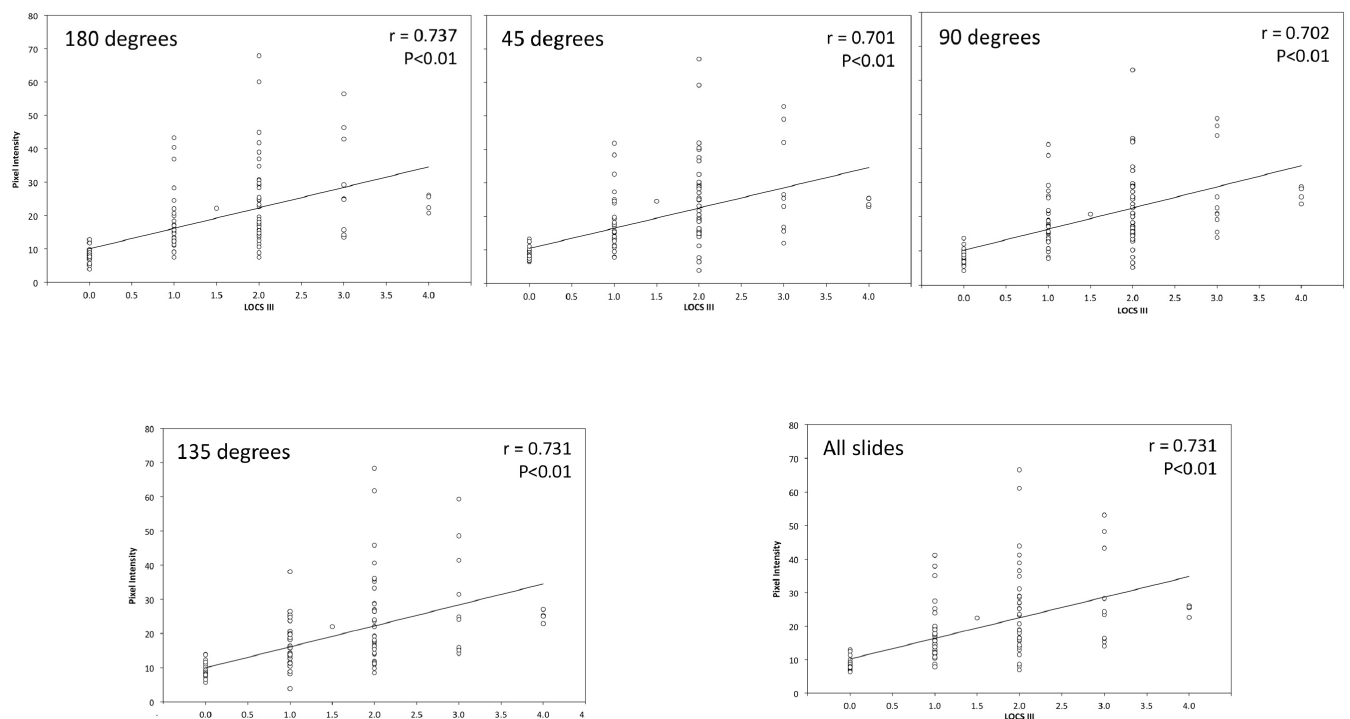
Fig 4. Scatter Plot Representing the Relationship between the Average Nuclear Intensity and LOCS III Grade for each Meridians. Top left panel represents the 180 degrees meridian; top centre panel does the 45 degrees meridian; top right panel represents the 90 degrees meridian; bottom left panel does the 135 degrees meridian; and the bottom right panel does the average of the four meridians.